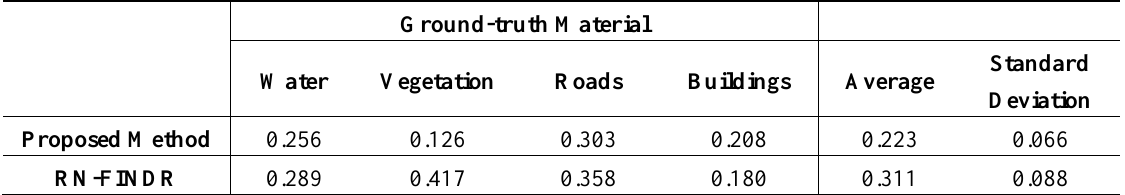
Table 8. RMSEs between ground-truth data and extracted endmembers in the CASI data obtained using the proposed method and